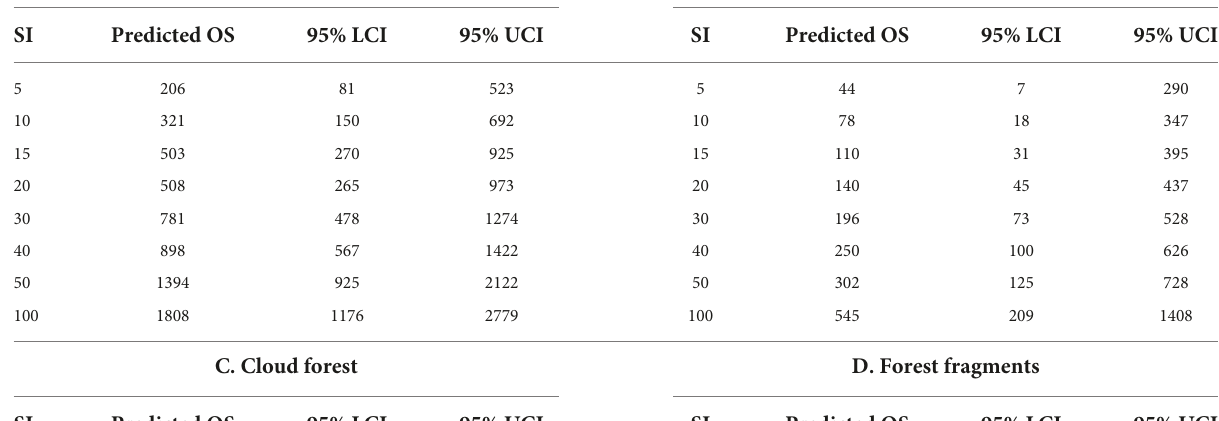
TABLE 3 Predicted dung beetle oversampling values (predicted OS) on their original scale (i.e., natural log exponential) as a function of sampling intensity (SI, number of traps) in different habitat types. A. Old-growth forest B. Tropical deciduous forest